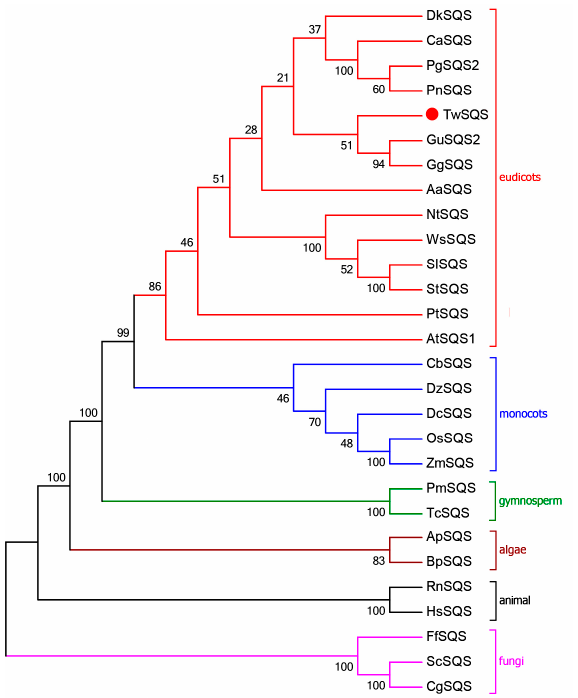
Figure 2. Phylogenetic analysis of TwSQS with other SQSs from diverse organisms constructed by the neighbor-joining method based on 1000 bootstrap replicates. The accession numbers of the aligned sequences are as follows: NtSQS, Nicotiana tabacum , AAB08578.1; WsSQS, W. somnifera , ADC95435.1; SlSQS, Solanum lycopersicum , NP 001234716.2; StSQS, Solanum tuberosum, BAA82093.1; PtSQS, Psammosilene tunicoides, ABQ96265.1; AtSQS1, Arabidopsis thaliana, AEE86403.1; CbSQS, Chlorophytum borivilianum , AFN61199.1; DzSQS, Dioscorea zingiberensis , AGN32410.1; OsSQS, Oryza sativa Japonica Group, BAA22557.1; DcSQS, Dendrobium catenatum , AGI56082.1; ZmSQS, Zea mays , BAA22558.1; PmSQS, Pinus massoniana , AHI96421.1; TcSQS, Taxus cuspidate , ABI14439.1; ApSQS, Auxenochlorella protothecoides , KFM22694.1; BpSQS, Bathycoccus prasinos , CCO17009.1; RnSQS, Rattus norvegicus , AAA42179.1; HsSQS, Homo sapiens , AAB33404.1; FfSQS, Fusarium fujikuroi , ABX64425.2; ScSQS, Saccharomyces cerevisiae , AAA34597.1.